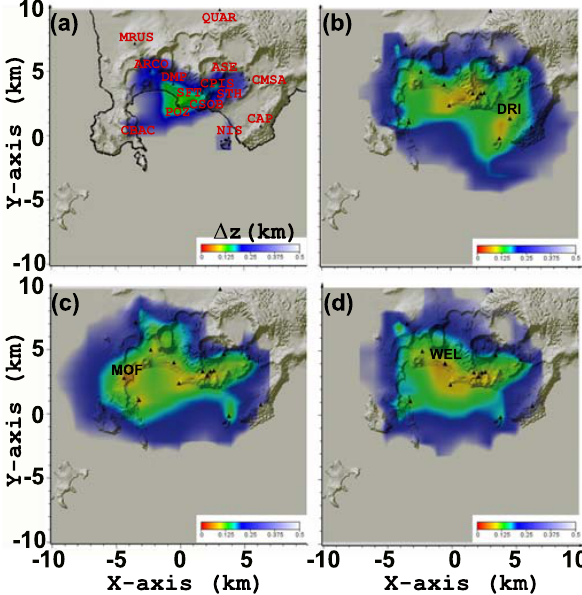
Fig. 2. Location errors (one standard deviation) on the vertical com- ponent obtained for earthquakes with M W = 0 . 5. The plan view is referred to the depth of 1km. Black triangles represent the seismic stations considered for the analysis. In (a) we show the errors com- puted using the stations of the permanent seismic network. Panel (b) show the errors computed using the actual network plus 5 sta- tions located in a borehole at point DRI; (c) same as (b) , but with borehole stations located at point MOF; (d) same as (b) , but with borehole stations located at point WEL. A number of 5 seismic sta- tions is considered in each borehole, respectively at depths: 0.25, 0.6, 1.1, 2.1 and 3.1km b.s.l. Axes dimension are